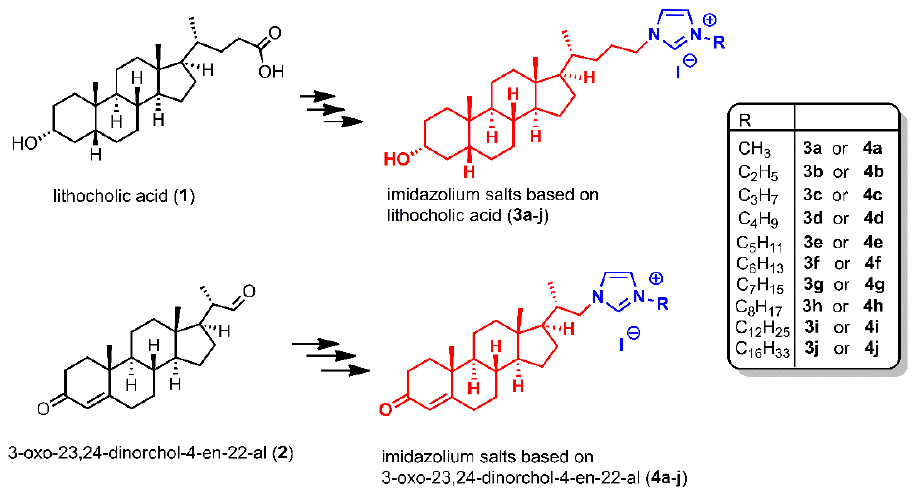
Figure 2. Two series of imidazolium salts tested in this